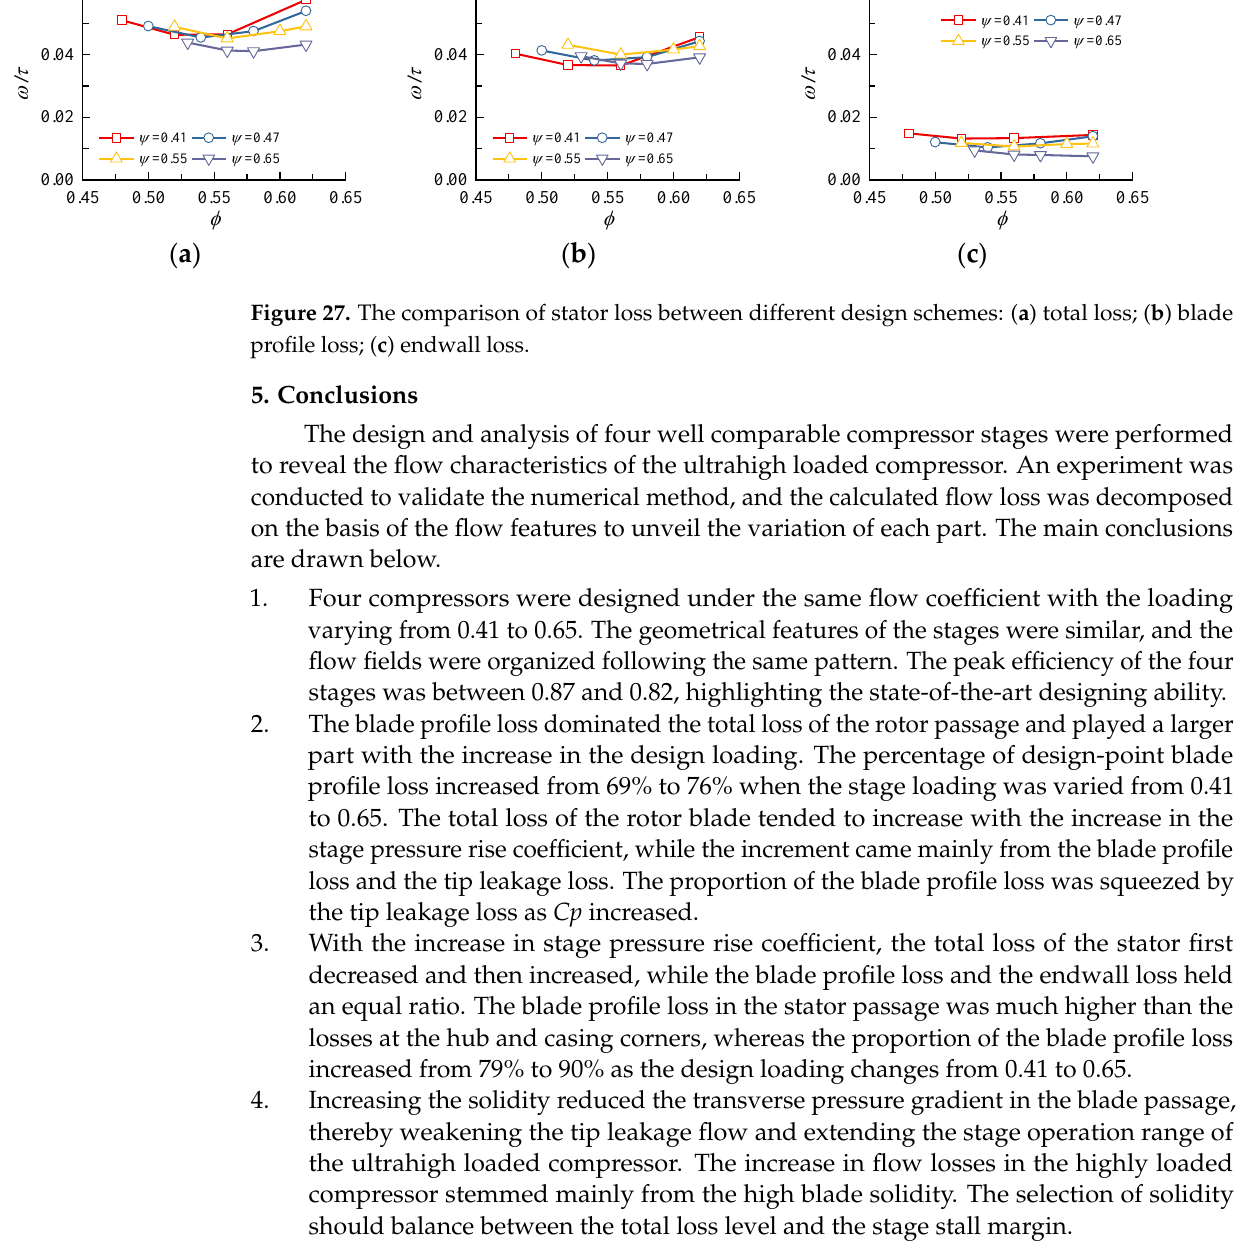
( c ) Figure 26. The comparison of rotor loss between different design schemes: ( a ) total loss; ( b ) blade profile loss; ( c ) tip leakage loss. The comparison of the stator passage loss is given in Figure 27, where the losses are divided by the blade solidity just like the rotor. The most striking result about the stator is that the higher loaded design generated a lower total loss in large mass flow rate con- ditions (see Figure 27a), where the ψ = 0.65 stage exhibited a lower loss level than the other stages. According to Figure 10, the stator solidity of the ψ = 0.65 stage was remarkably higher than that of the other three schemes, thus relieving the loading of every single